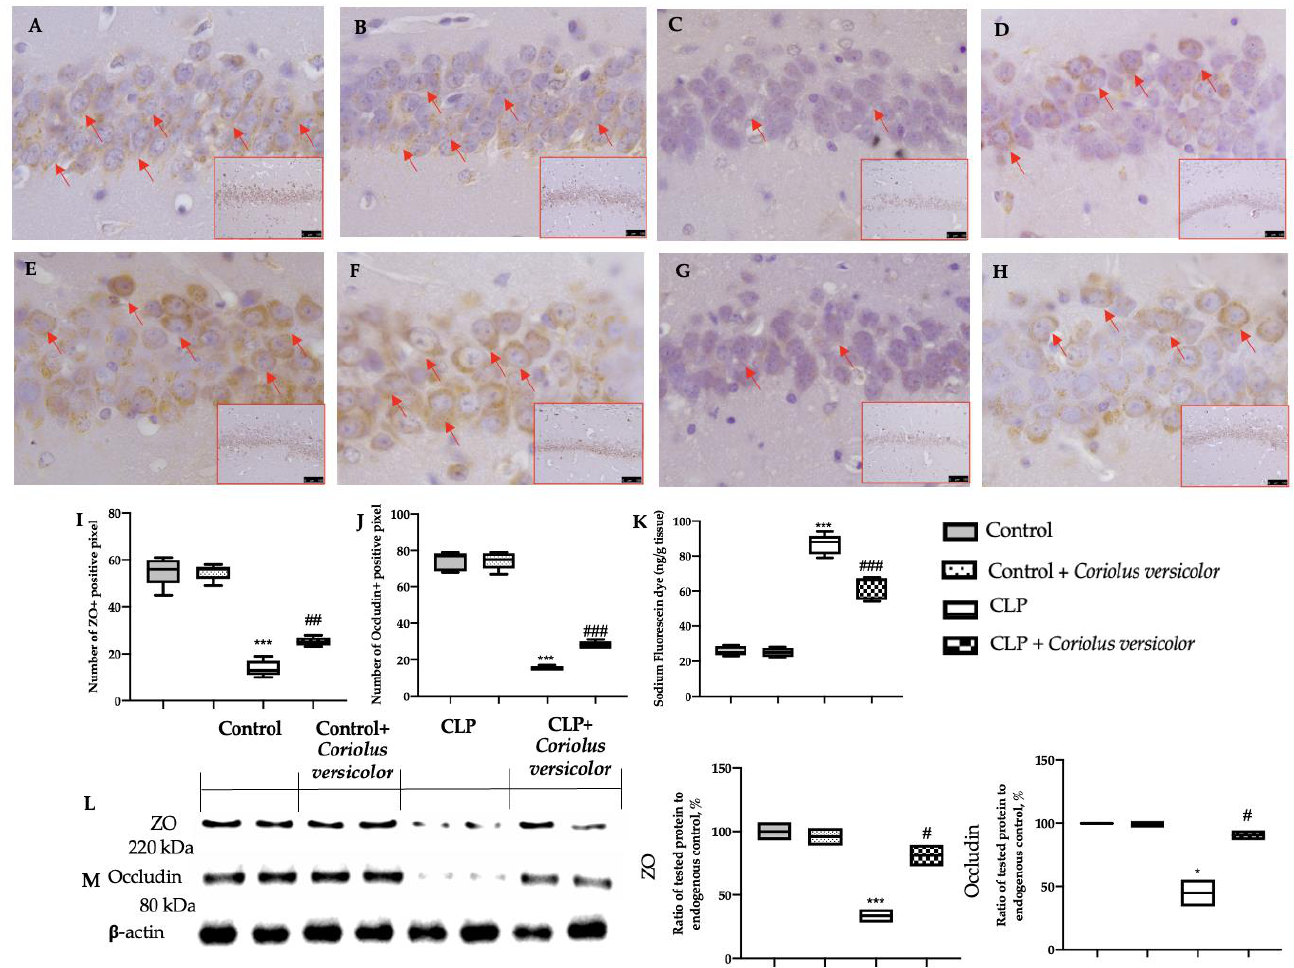
Figure 4. Coriolus versicolor reduced tight junctions alterations in the hippocampus 28 days after CLP. Immunohistochemical analysis of zona occludens (ZO): Control ( A ), Control + Coriolus versicolor ( B ), CLP ( C ), CLP + Coriolus versicolor ( D ), immunohistochemical analysis of occludin: Control ( E ), Control + Coriolus versicolor ( F ), CLP ( G ), CLP + Coriolus versicolor ( H ). Graphical quantification of ZO expression ( I ); graphical quantification of ZO expression ( J ). Sodium fluorescein extravasation ( K ). Western blot analysis of ZO ( L ), occludin ( M ). * p < 0.05 vs. Control, # p < 0.05 vs. CLP, ## p < 0.01 vs. CLP, *** p < 0.001 vs. control, ### p < 0.001 vs. CLP.